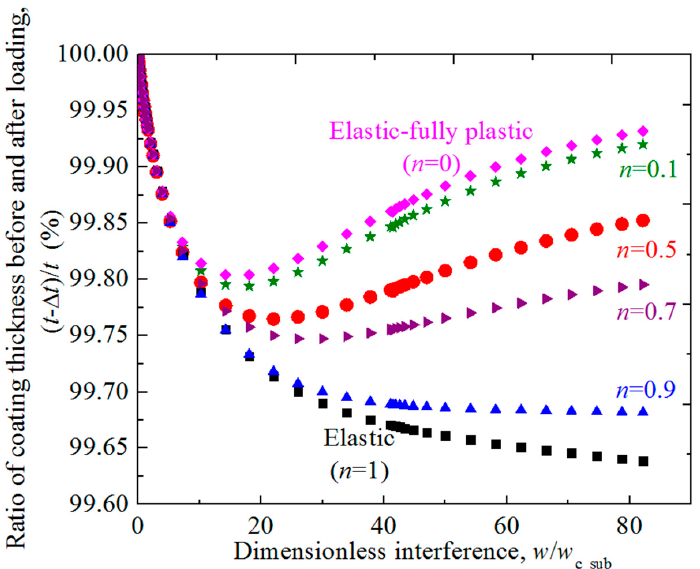
Figure 7. The ratio of coating thickness before and after loading ( t − Δ t )/ t changing with the dimensionless interference w/w c_sub for typical cases where hardening exponent n = 0.1, 0.5, 0.7, 0.9 for dimensionless coating thickness t/R = 0.01 and Young’s modulus ratios E co /E su = 4. The elastic ( n = 1) and elastic fully-plastic ( n = 0) cases are also considered.